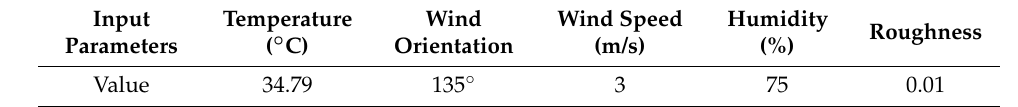
Table 2. Initial input values of weather parameters for the simulation model.